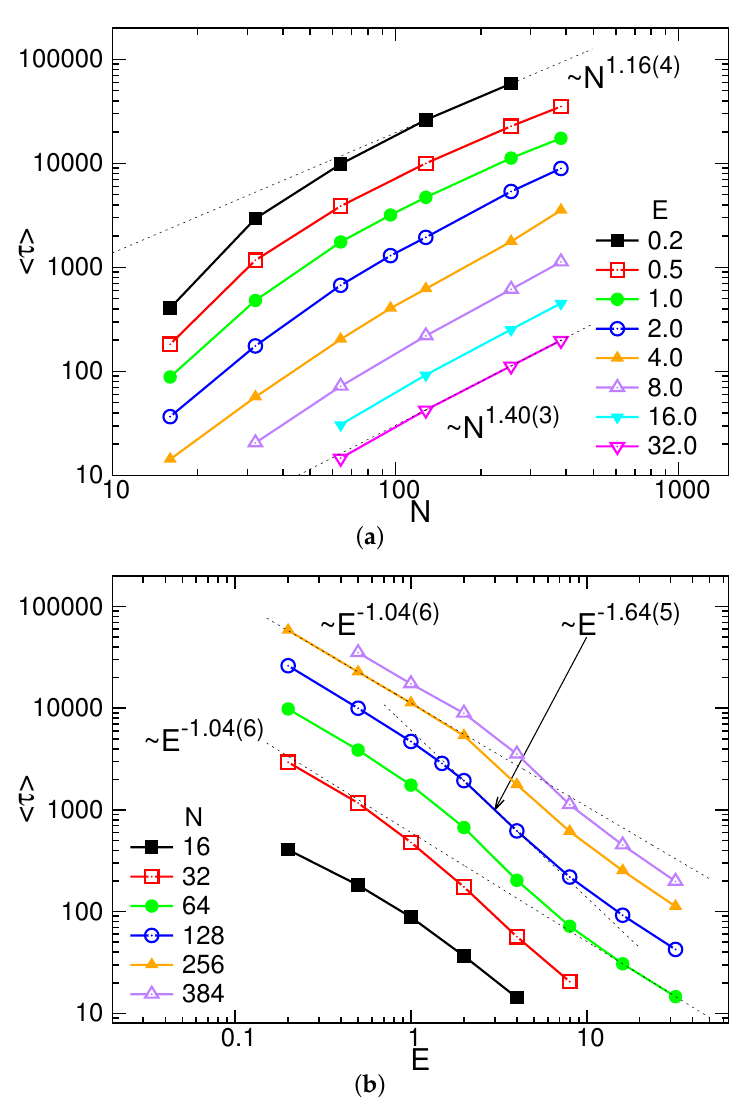
Figure 3. Mean translocation time (cid:104) τ (cid:105) as a function of ( a ) chain length N at a given E , and ( b ) field strength E at a given N . The error bar is smaller than the data